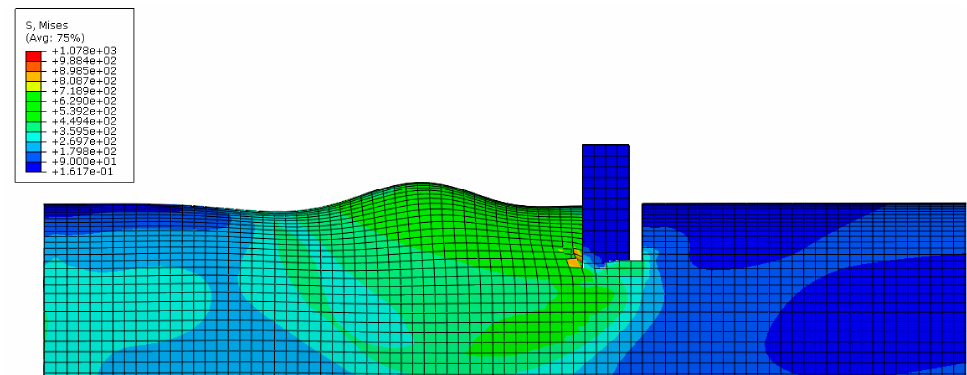
Figure 9. von Mises stress distribution of the tube under localised transverse compression (lateral view, Case 10).